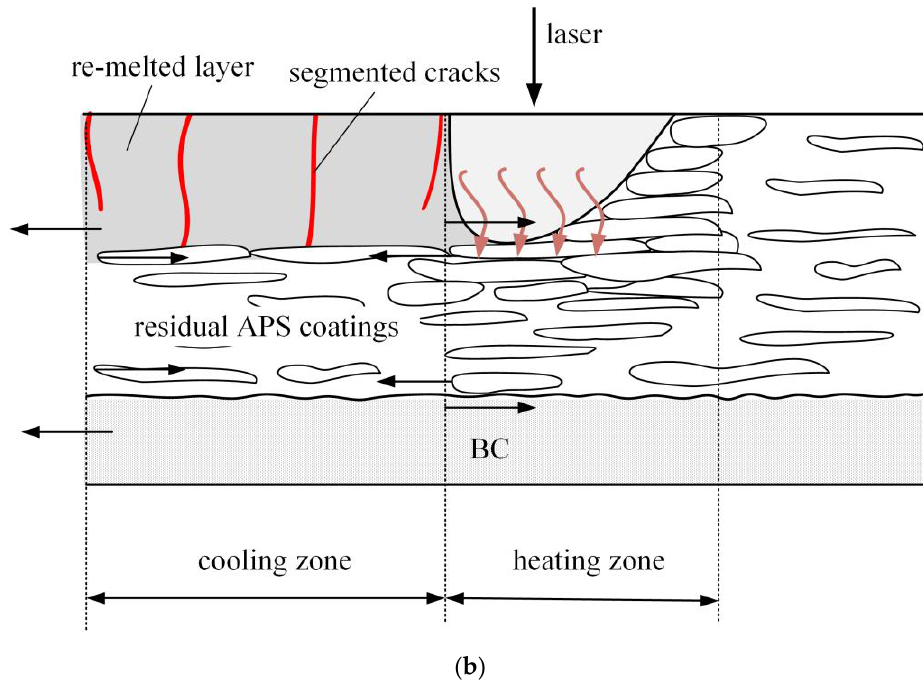
Figure 8. The schematic of microstructure evolution of ( a ) non-preheating sample and ( b ) preheating sample during the laser re-melting process.